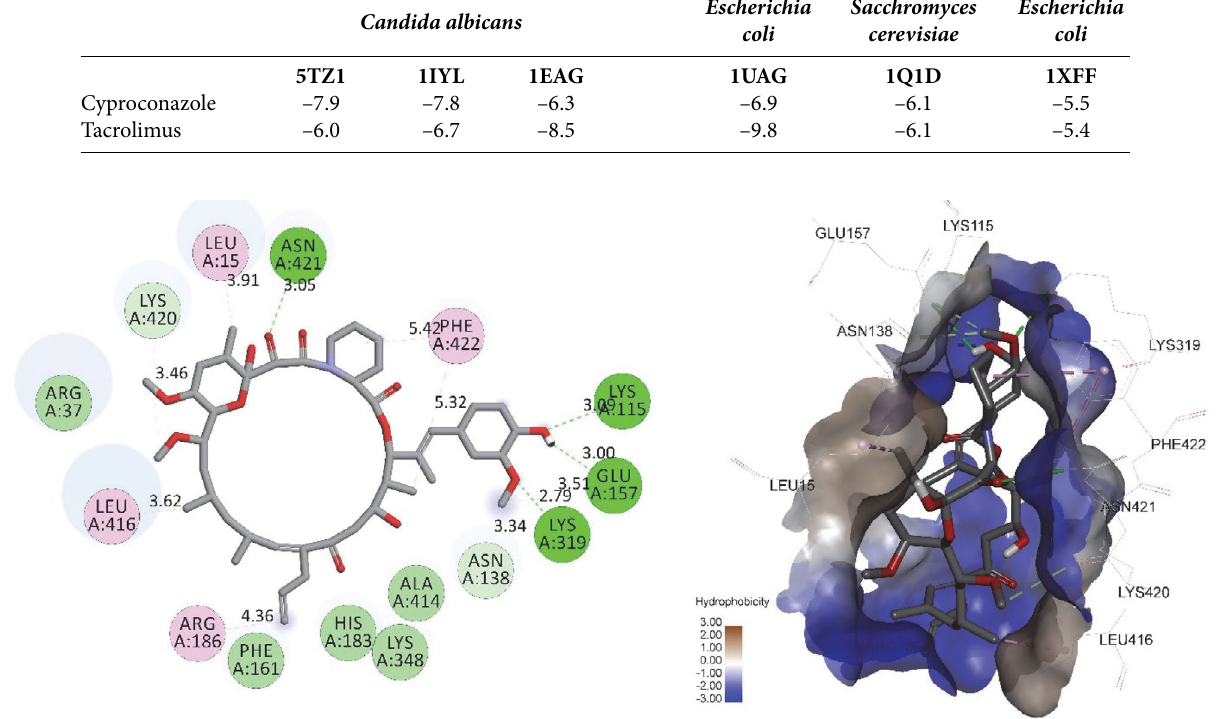
Table 3. Affinity to binding sites The calculated affinity of substances to binding sites of sterol 14 α -demethylase (CYP51) 5TZ1, N -myristoyltransferase (NMT) 1IYL, secreted aspartic proteinase (SAP2) 1EAG, UDP- N -acetylmuramoyl- L -alanine: D -glutamate ligase (MurD) 1UAG, topoisomerase II (Topo II) 1Q1D, and L -glutamine: D -fructose-6-phosphate amidotransferase (GlcN-6-P) 1XFF. Substance